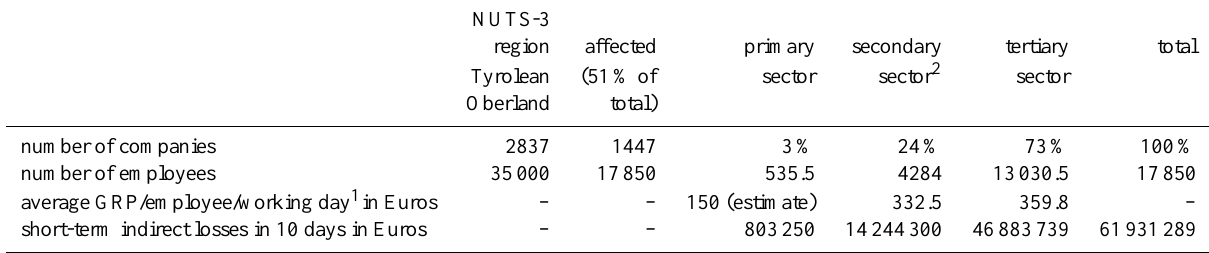
Table 4. Estimates of short-term economic losses of the 2005 floods in NUTS-3 region Tyrolean Oberland; source: Statistics Austria and authors’